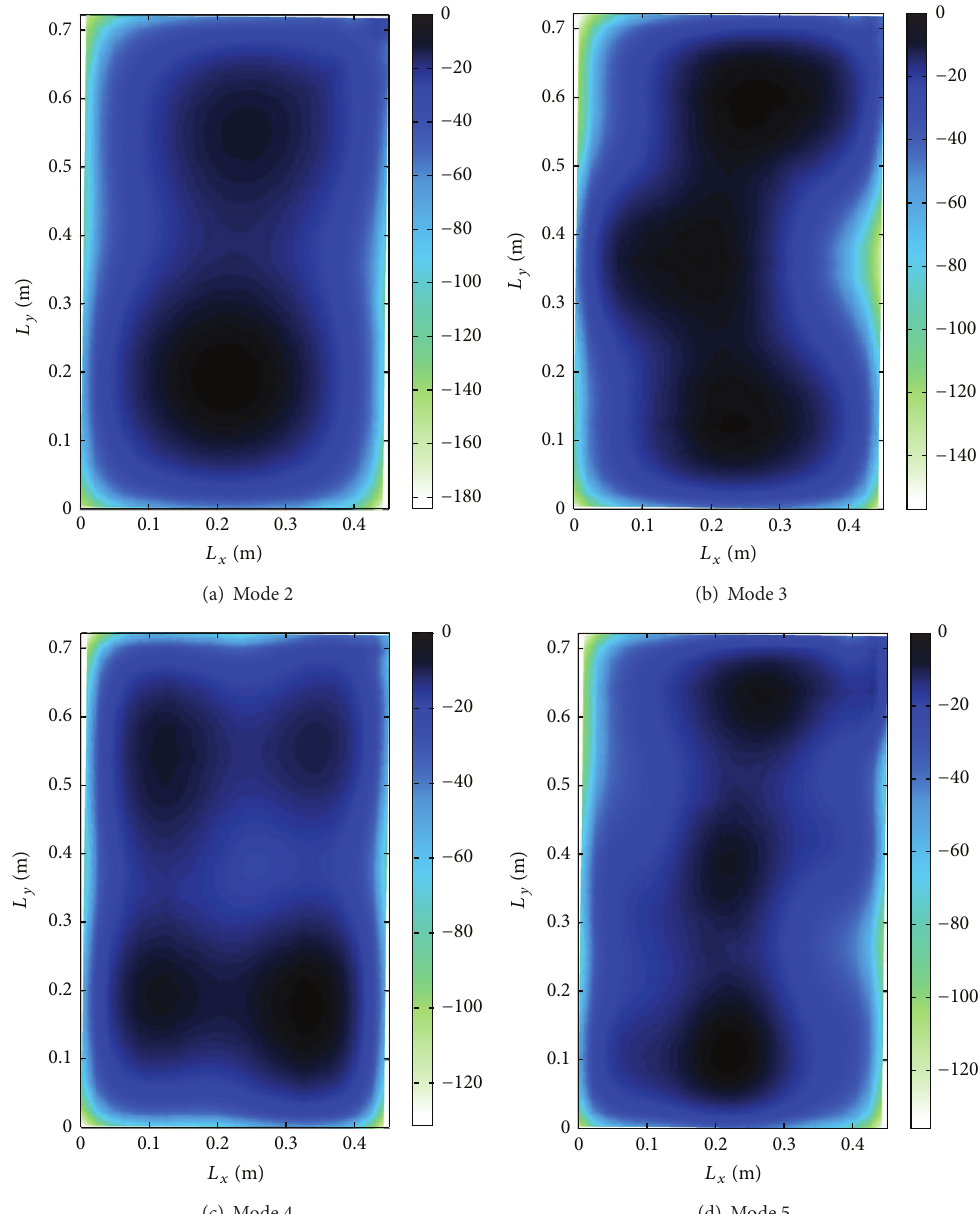
Figure 18: Plots of the WSSG field measured experimentally at the natural frequencies of modes